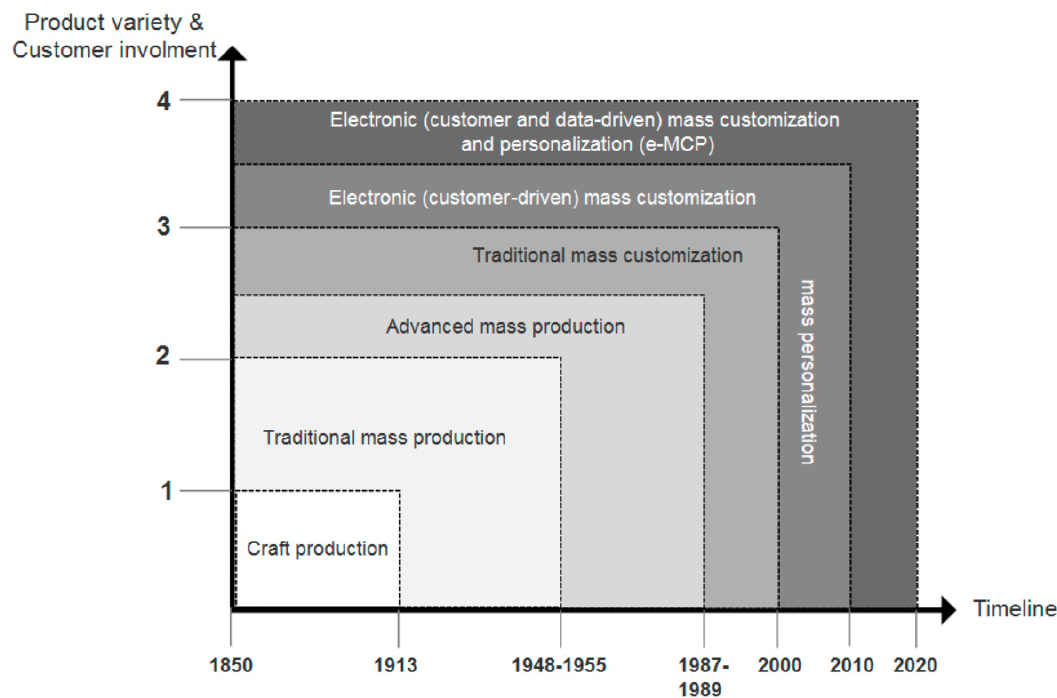
Figure 1. Historical background and evolution of the Mass Customization concept. Source: Composed by the authors according to Aniši´c et al. (2013); Kanama (2018); Zhang et al. (2019). The main transformation stages of MC are based on two criteria: (a) a timeline of history